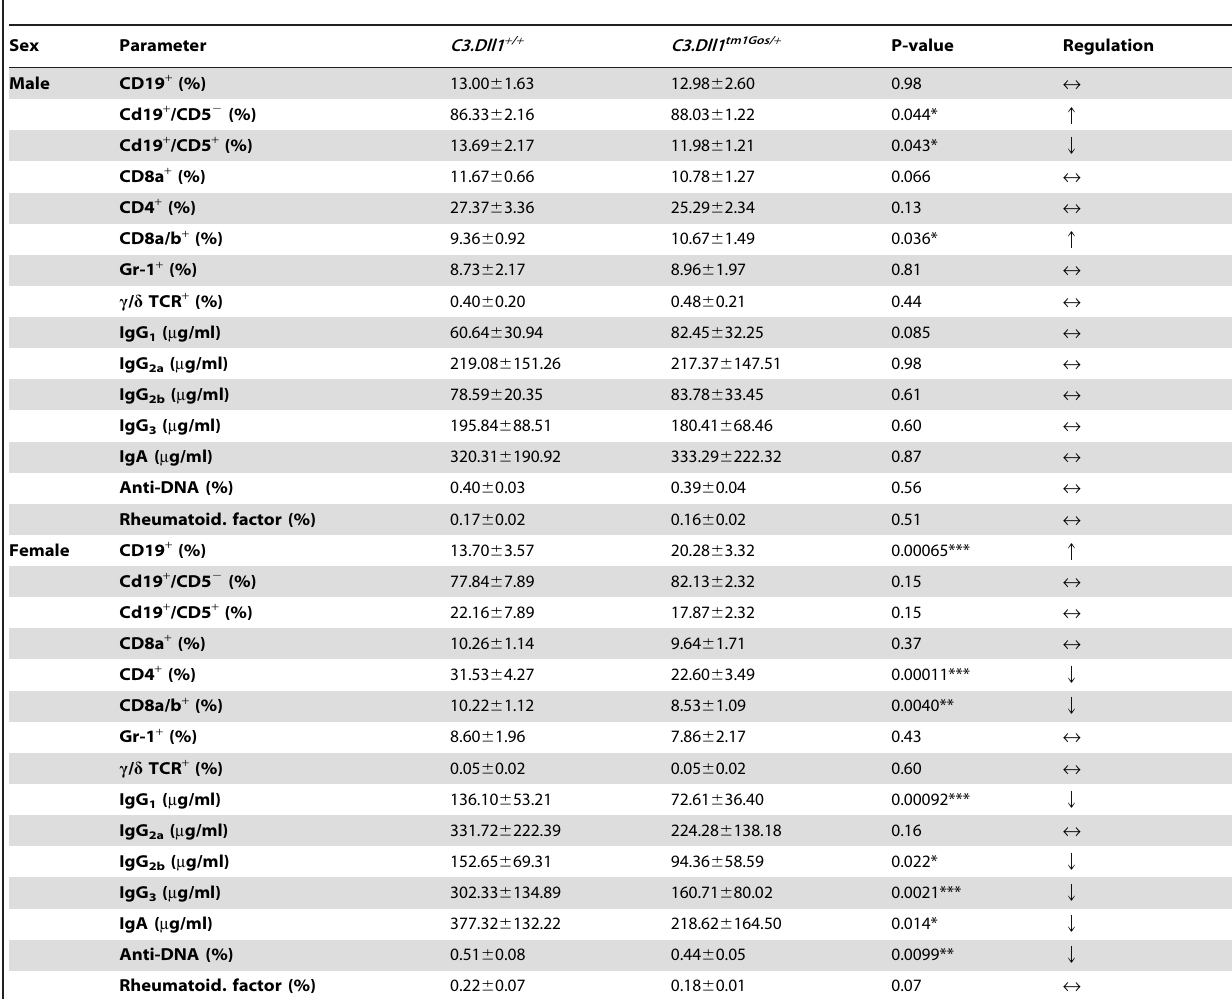
Table 1. Immunological parameters in heterozygous C3.Dll1 tm1Gos/ + animals.